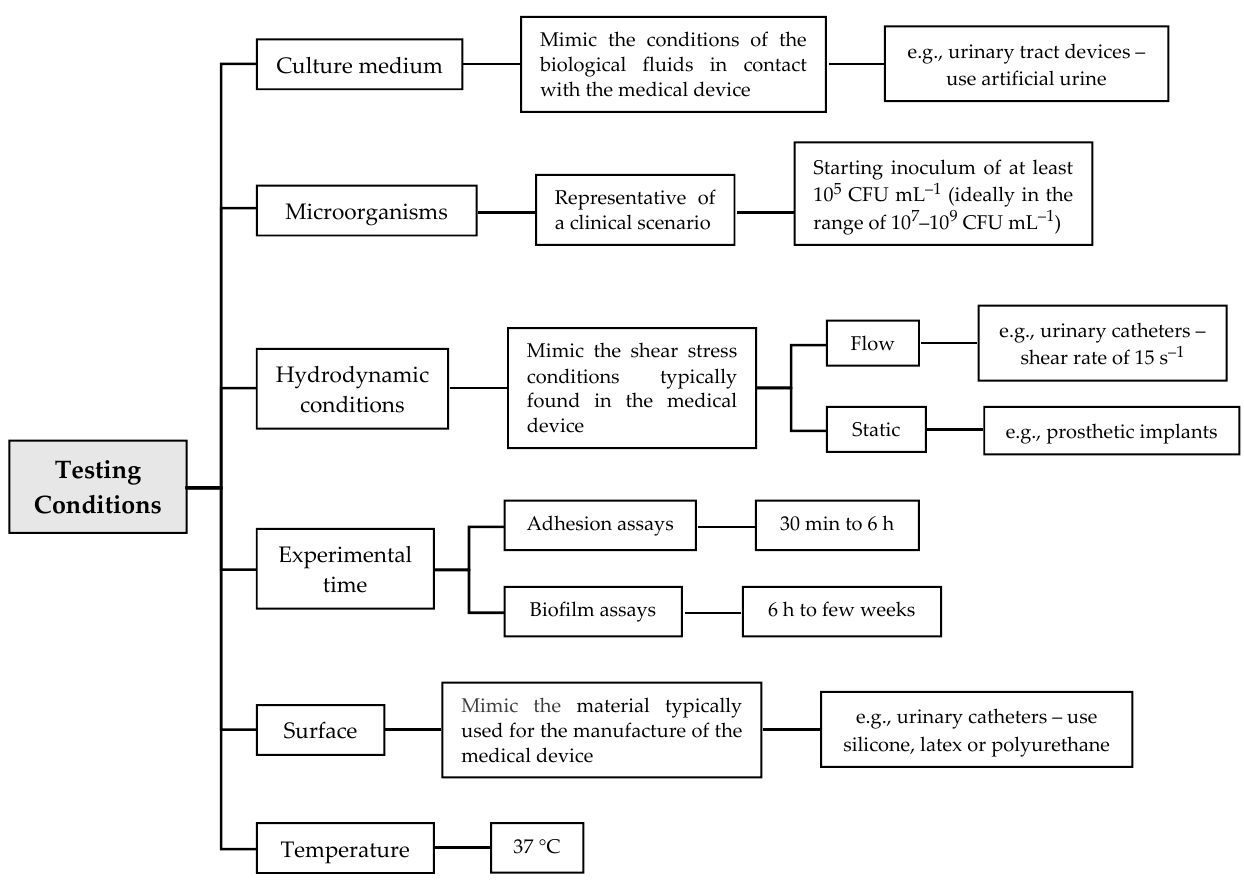
Figure 3. Proposal of testing conditions to be adopted in future studies.